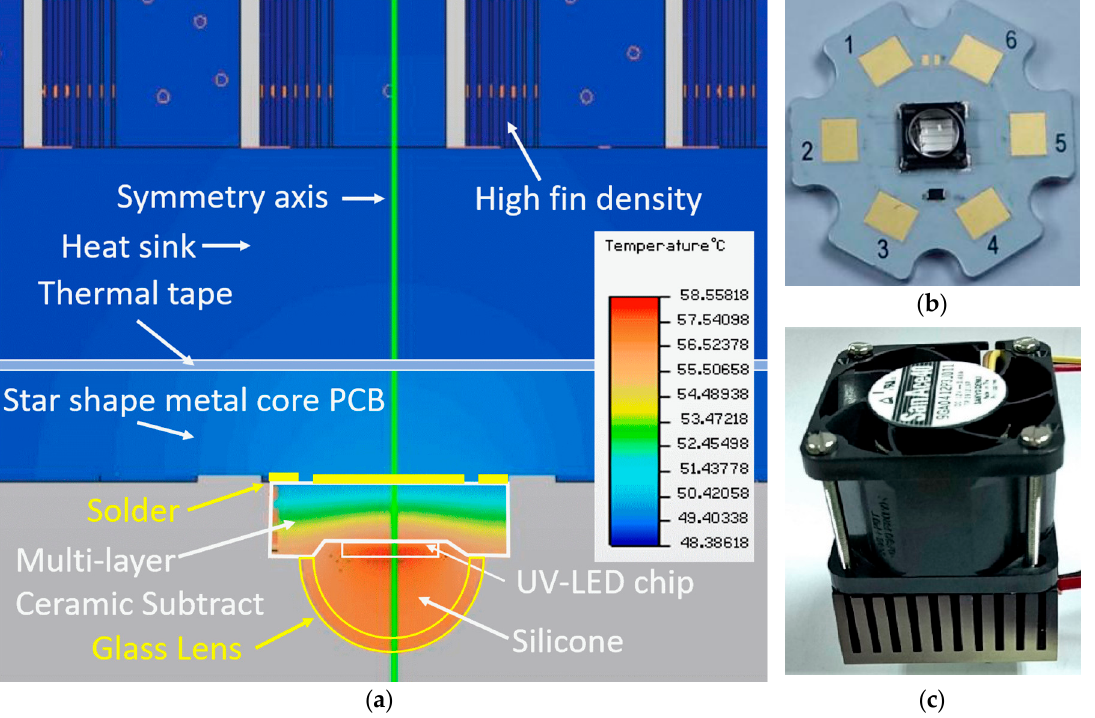
Figure 1. ( a ) Diagram and thermal simulation results (T a = 40 °C) of the high power ultraviolet light-emitting diode in a natural convection configuration: LED, star-shaped metal core printed circuit board (MCPCB), thermal tape, and heat sink; ( b ) photograph of the star-shaped MCPCB with the UV LED in the center and black protection device below; ( c ) photograph of the UV LED in a forced configuration, with a fan over the heat sink.